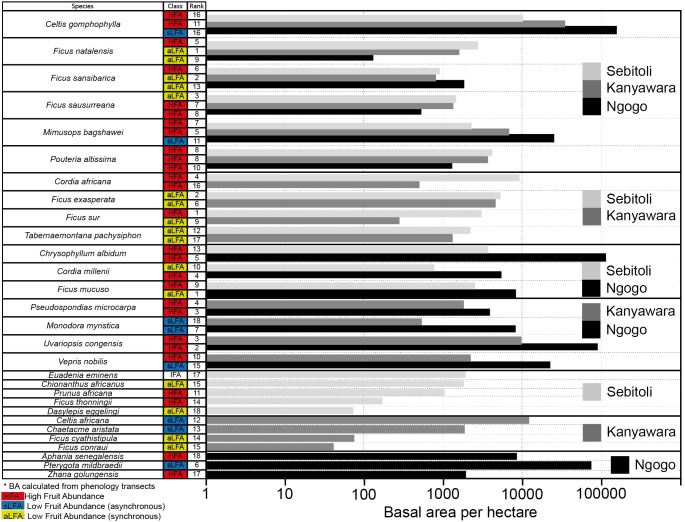
Sum of 18 most consumed species basal area, fruit availability and consumption rank at Sebitoli, Kanyawara and Ngogo (data for Kanyawara and Ngogo from [30]).
Morus lactea (sLFA) and Treculia africana (HFA) at Ngogo were absent from plots but present in Ngogo chimpanzee diet.